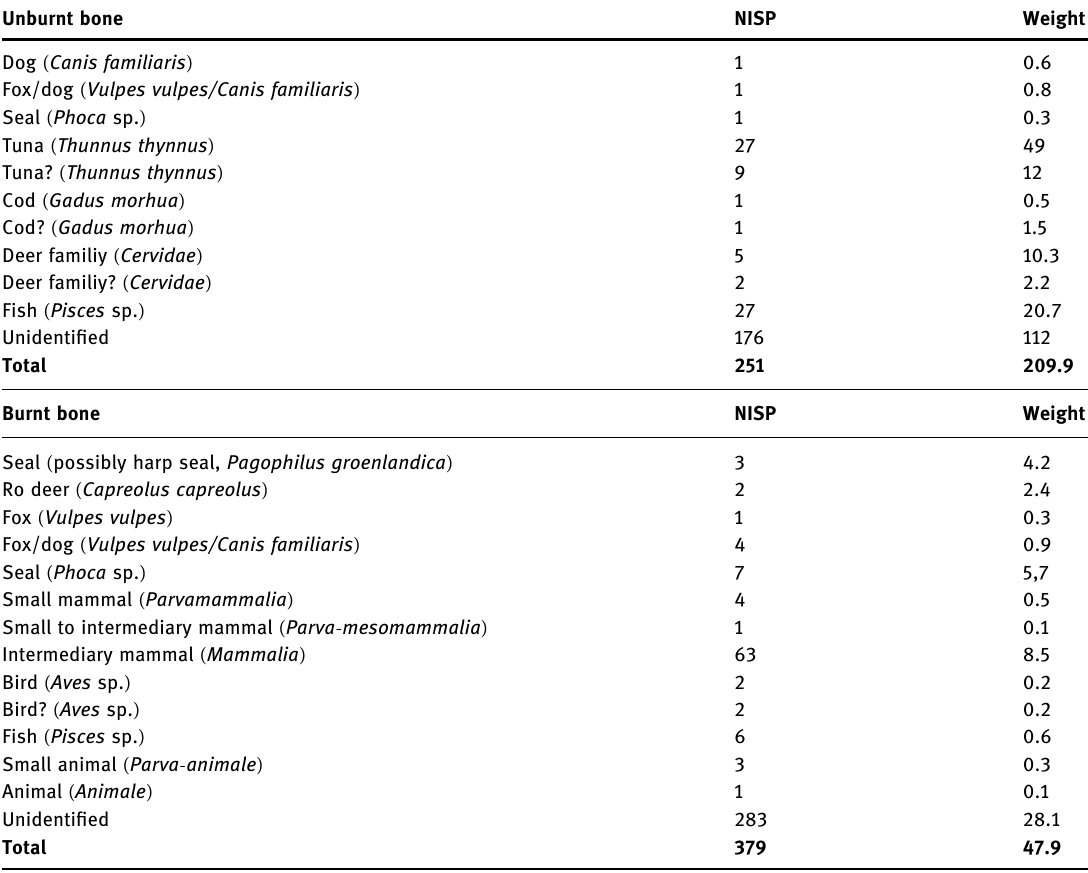
Table 1: Burnt and unburnt animal bones from the Alveberget site. Osteological analysis performed by Prata and Sjöling ( 2019 )